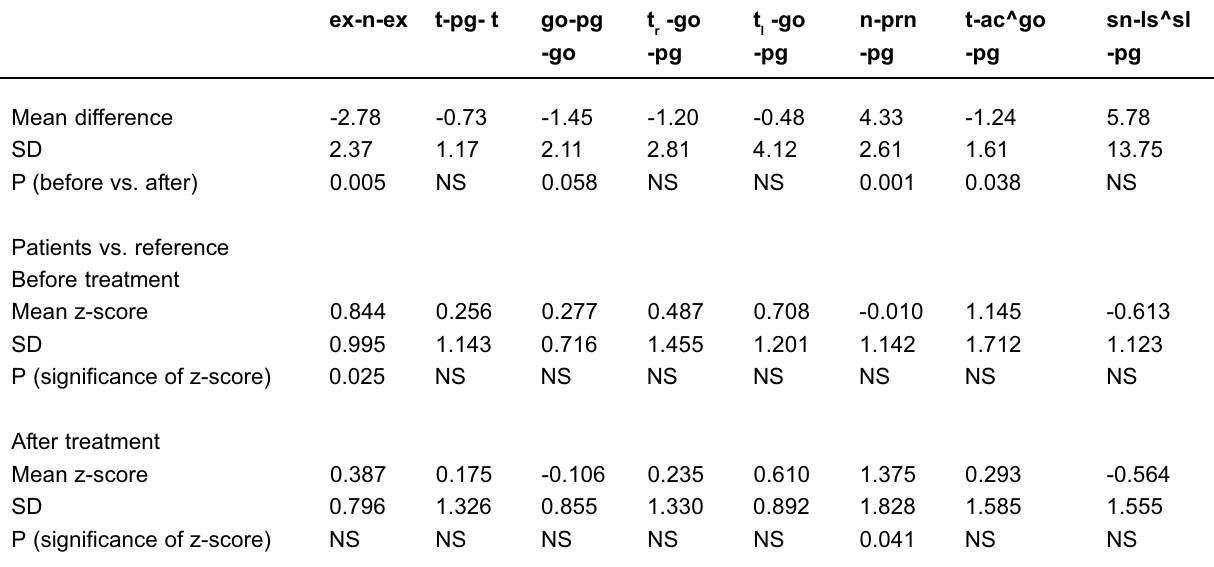
Differences are expressed in degrees. Patients vs. reference: values are z-score units. P (before vs. after): probability of a paired Student’s t test; null hypothesis: no difference before and after treatment. P (significance of z-score): probability of a paired Student’s t test; null hypothesis: the mean z-score is 0. NS: not significant. p > 0.05. SD = standard